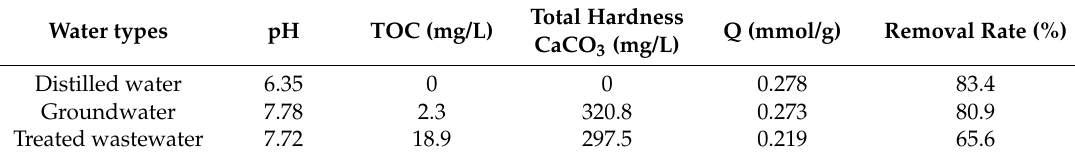
Table 9. Chemical characteristics of water types and removal of